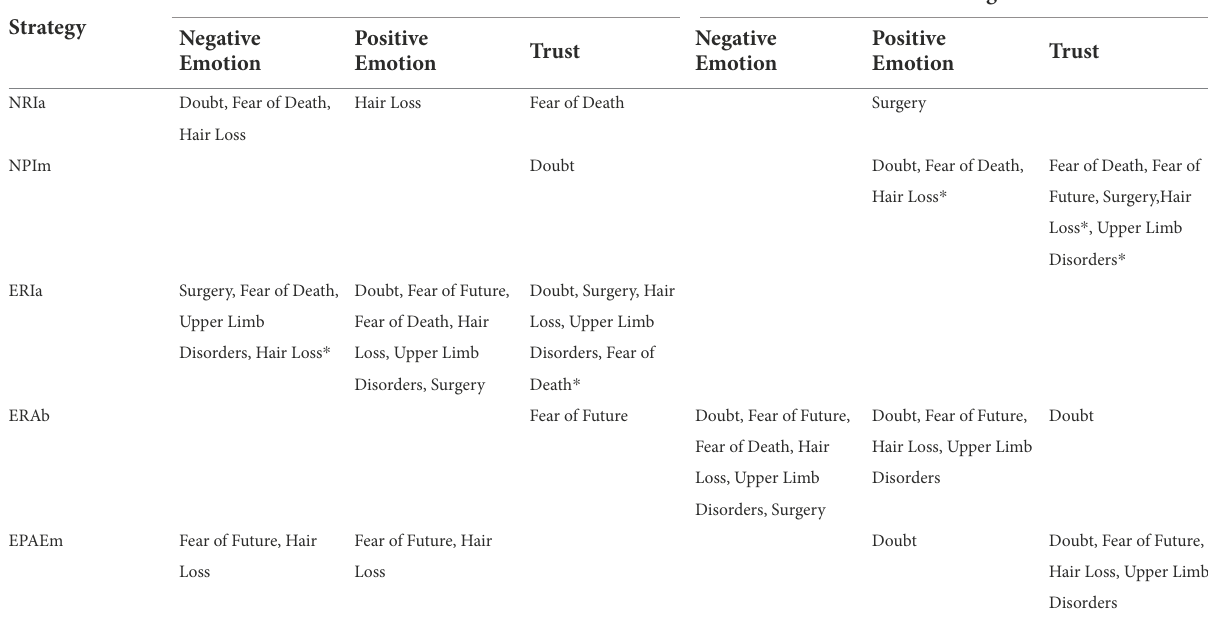
TABLE 6 The strategy matrix based on the ANOVA results.